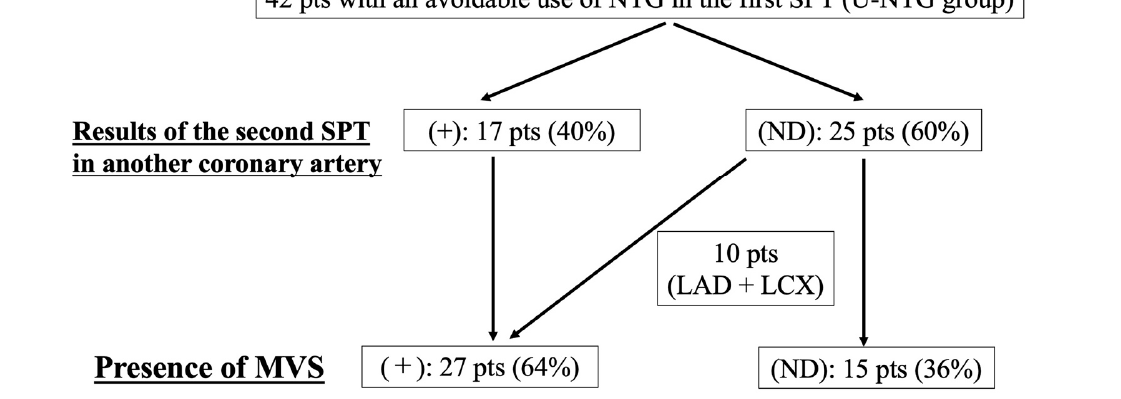
Figure 3. Flowchart of the SPT protocol for the 42 patients who underwent an unavoidable use of NTG in the first SPT. LAD, left anterior descending coronary artery; LCX, left circumflex coronary artery; ND, not diagnosed; NTG, nitroglycerin; SPT, spasm provocation test; U-NTG, unavoidable use of nitroglycerin.